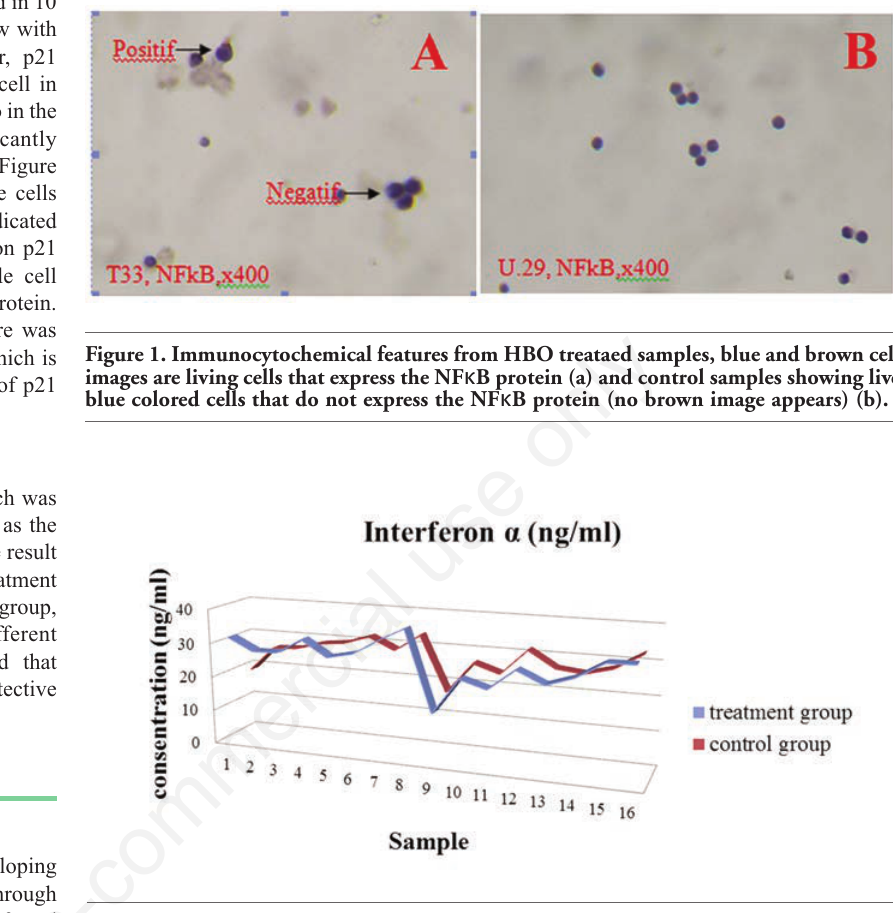
Figure 2. Interferon concentration after hyperbaric treatment by ELISA. α